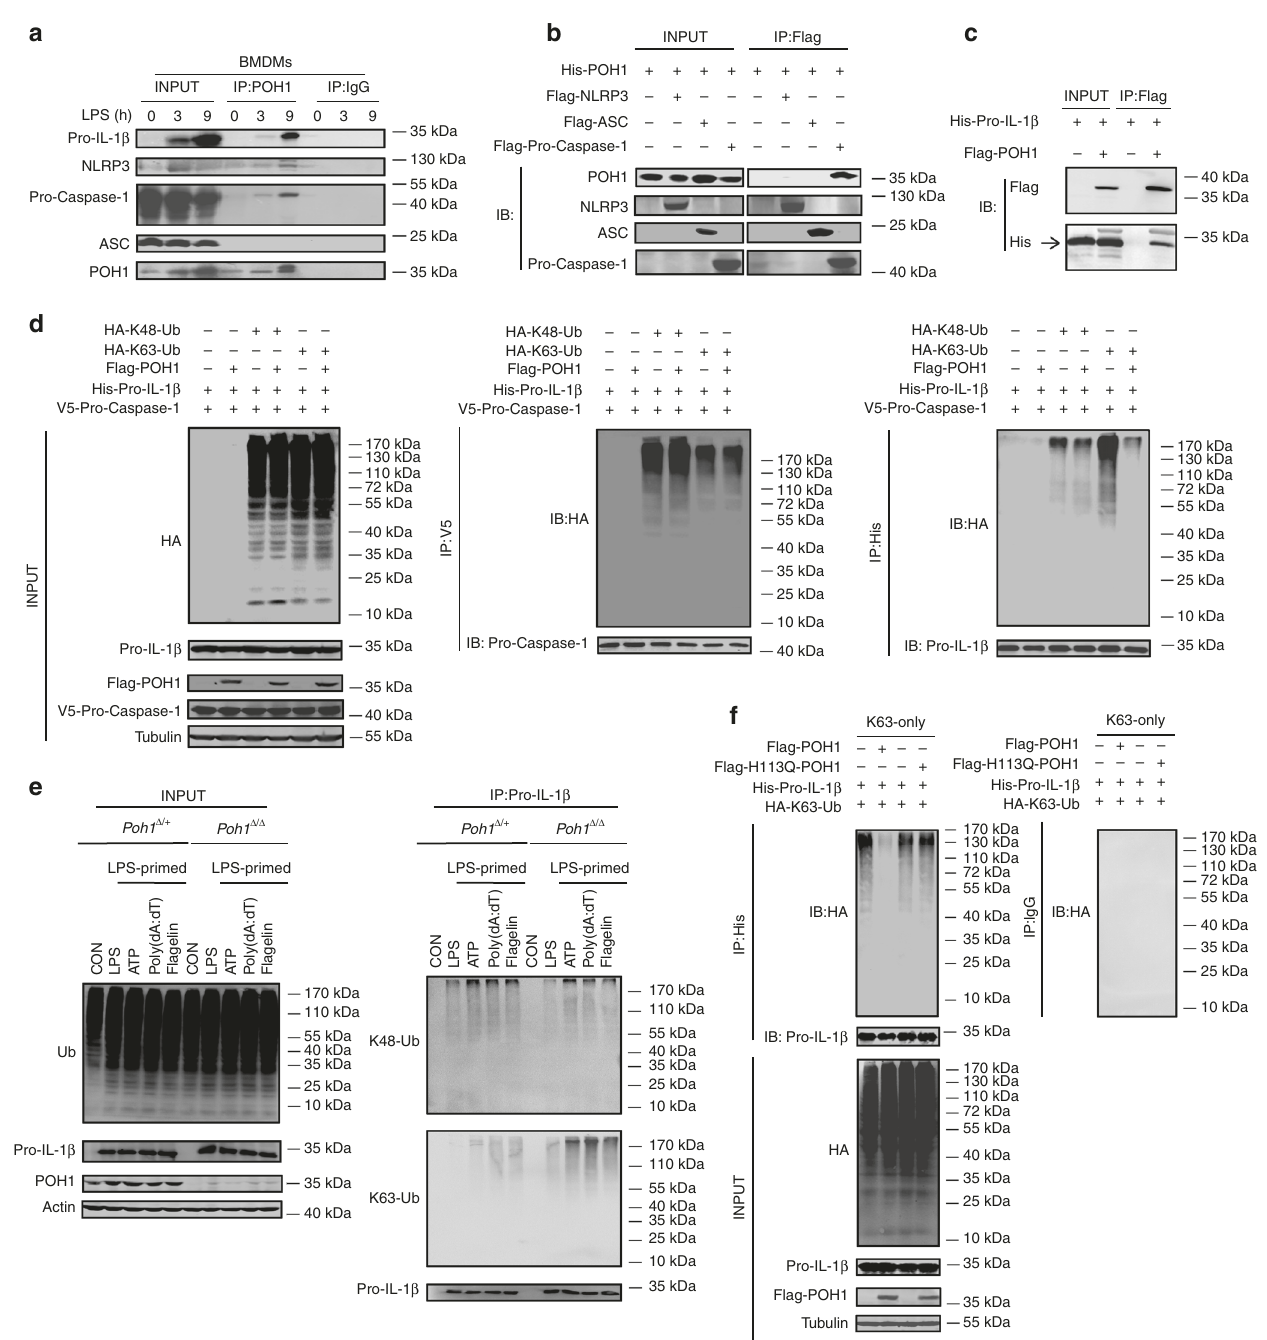
Fig. 5 POH1 negatively modi fi es K63-linked polyubiquitination of pro-IL-1 β . a BMDMs stimulated with LPS for the indicated time periods were immunoprecipitated (IP) with an anti-POH1 or control IgG antibody and immunoblotted (IB) with the indicated antibodies. b HEK293T cells transfected with His-POH1 and either Flag-NLRP3, Flag-caspase-1 or Flag-ASC were subjected to IP with an anti-Flag antibody and IB with an anti-His antibody. c The lysates of HEK293T cells expressing Flag-POH1 and His-pro-IL-1 β were IP with an anti-Flag antibody and IB with an anti-His antibody in cell lysates. d HEK293T cells transfected with Vsv-ASC, V5-tagged pro-caspase-1, HA-tagged K48-only or K63-only Ub and His-tagged pro-IL-1 β , along with or without Flag-tagged POH1, were subjected to IP with an anti-V5 antibody or anti-His antibody and then IB with the indicated antibodies. e Poh1 Δ / + and Poh1 Δ / Δ BMDMs treated as indicated were subjected to IP with an anti-pro-IL-1 β antibody and IB with the indicated antibodies. f HEK293T cells were transfected with Flag-caspase-1, Vsv-ASC, His-pro-IL-1 β , Flag-POH1 (WT) or Flag-H113Q-POH1, along with HA-tagged K63-only Ub, then cells were subjected to IP with an anti-His or control IgG antibody and IB with the indicated antibodies. Similar results were obtained from three independent